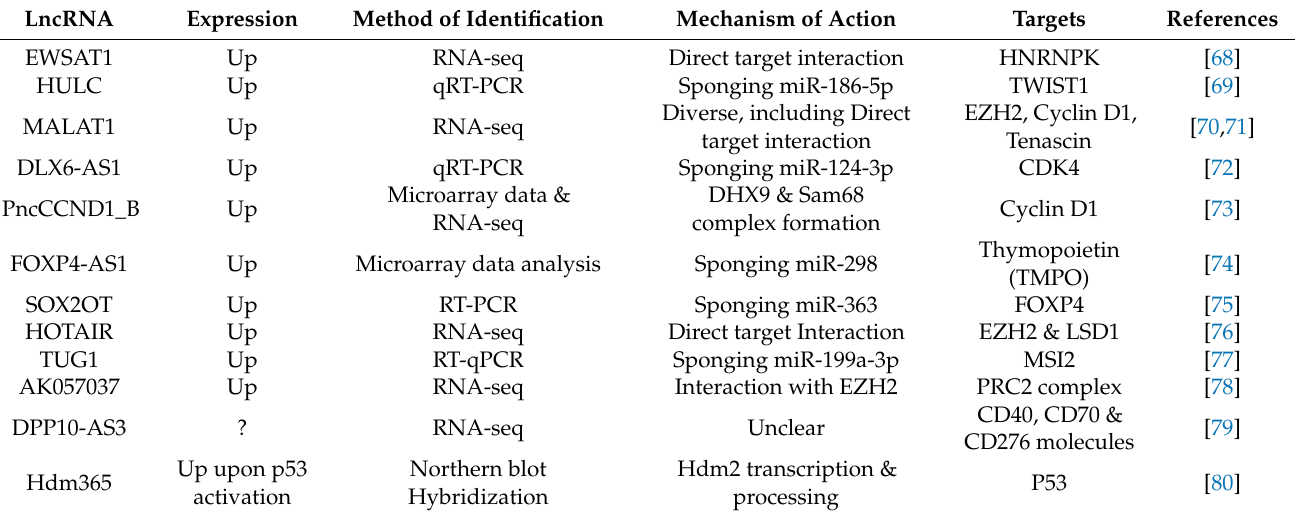
Table 1. LncRNAs so far identified in Ewing